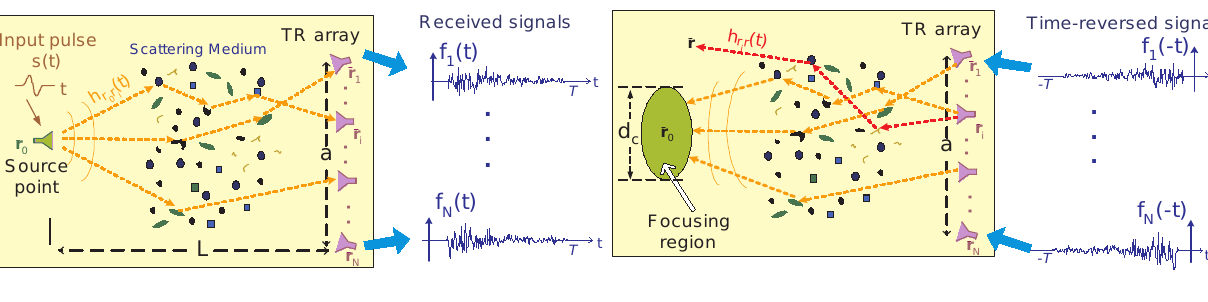
Figure 1. Time reversal experiment using a limited aspect array. (left) Forward Propagation of the short input pulse, (right) Backward Propagation of the time-reversed